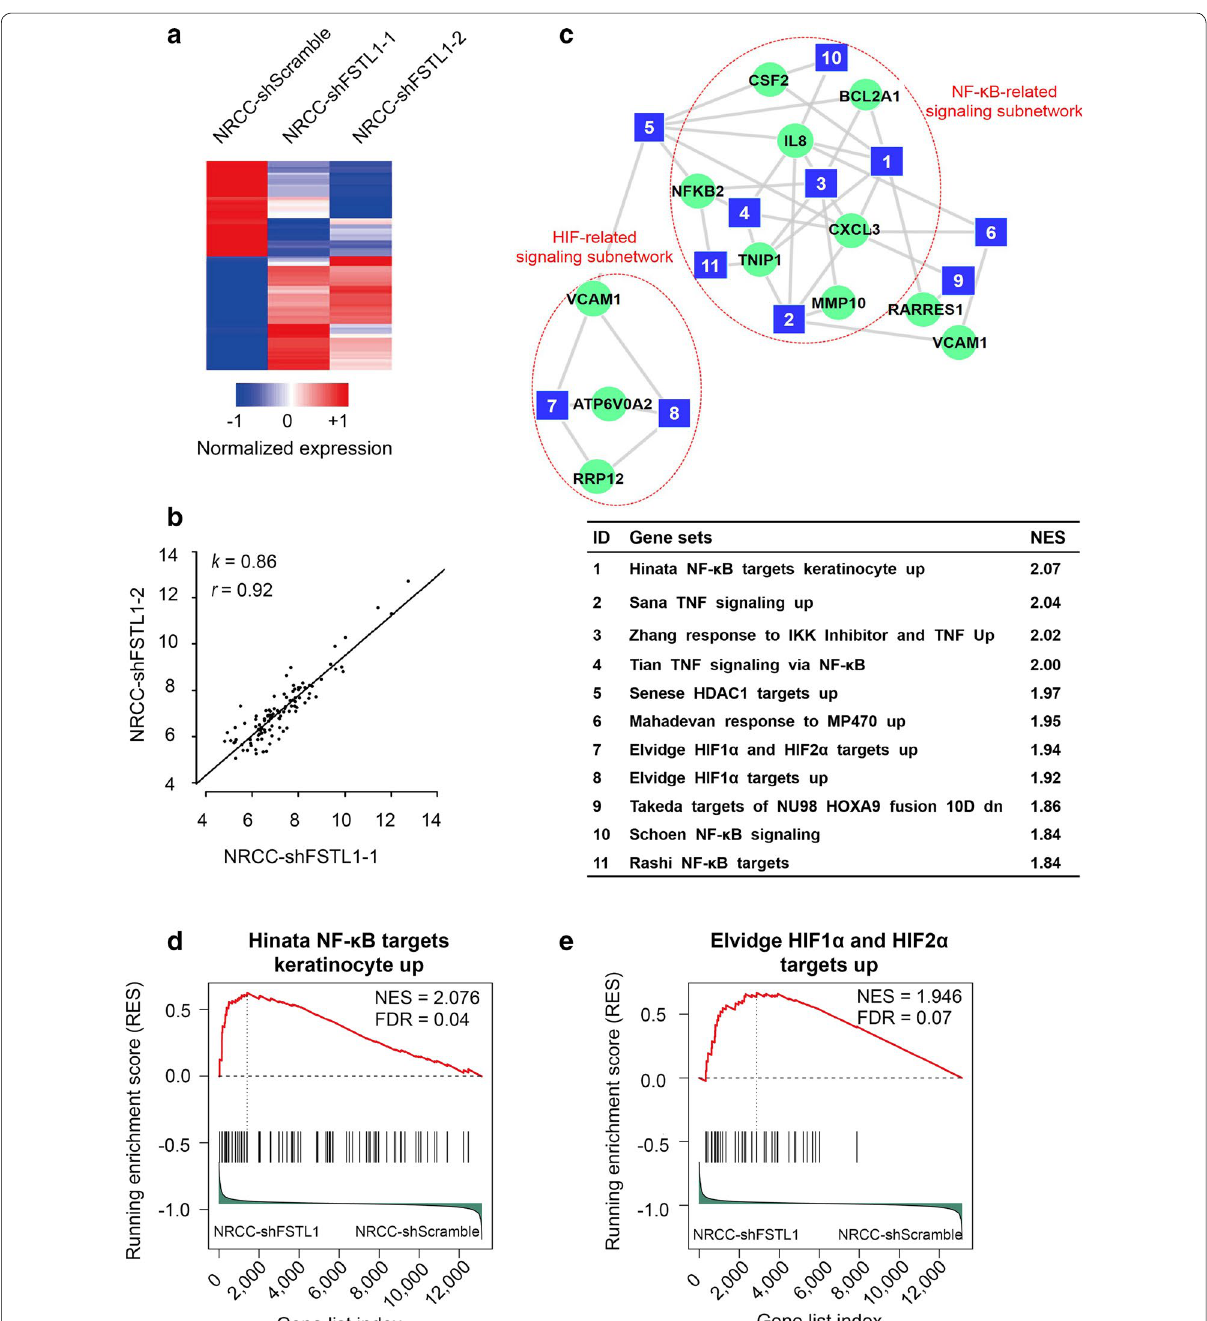
Fig. 4 Major signaling pathways enriched by up-regulated genes in FSTL1 -knockdown ccRCC cells by microarray assay. a Heat map of 105 differ- entially expressed genes (48 down-regulated and 57 up-regulated). b Reproducibility of the 105 differentially expressed genes in NRCC-shFSTL1-1 and NRCC-shFSTL1-2 cells (Pearson correlation coefficient r 0.92; scope of linear model k 0.86, P < 0.001). c Ranked by normalized enrichment = = score (NES), the top 11 gene sets (blue squares) enriched by up-regulated genes in response to FSTL1 knockdown are selected to plot the network. Intersection genes (green dots) with fold change > 2 were plotted to connect the gene sets. The gene sets fell into nuclear factor- к B (NF-κB)- and hypoxia-inducible factor (HIF)-related signaling subnetworks, respectively, which is connected by a histone deacetylase 1 (HDAC1)-related gene sets. d Enrichment plot of the representative gene set with the highest NES score in the NF-κB-related signaling subnetwork. e Enrichment plot of the representative gene set with the highest NES score in the HIF-related signaling subnetwork. The vertical dashed line in each plot denoted the point at which NES reached its